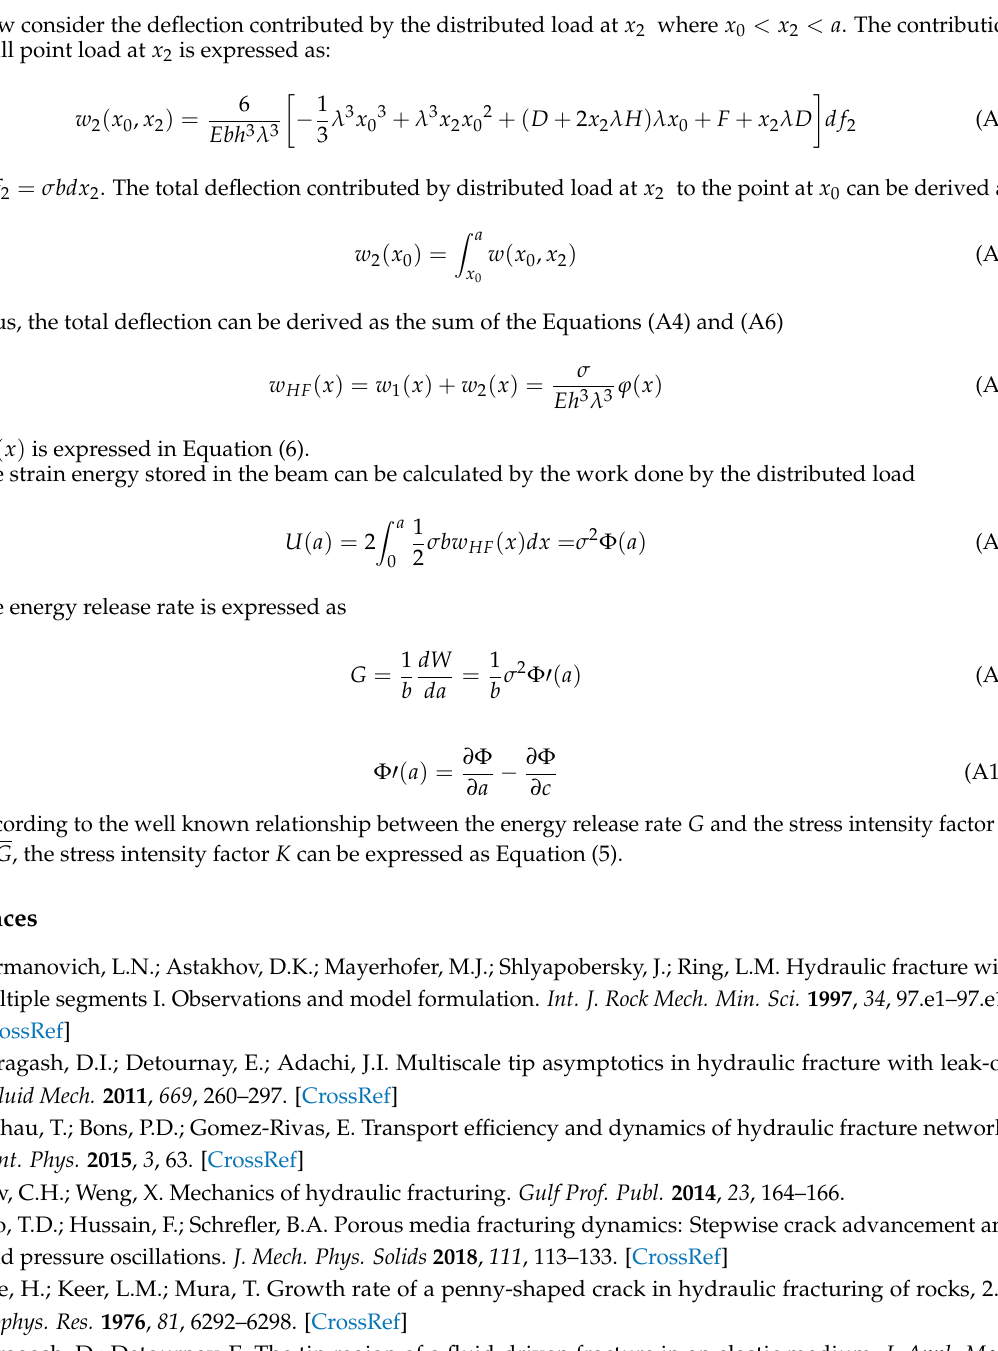
Figure A1 . Schematics of beam deflection. The total deflection is the sum of 𝑤 1 and 𝑤 2 . Both 𝑤 1 and 𝑤 2 are calculated by regarding the distributed load as infinite numbers of small point loads. The coordinate is not the same as the coordinate used in Figure 4.